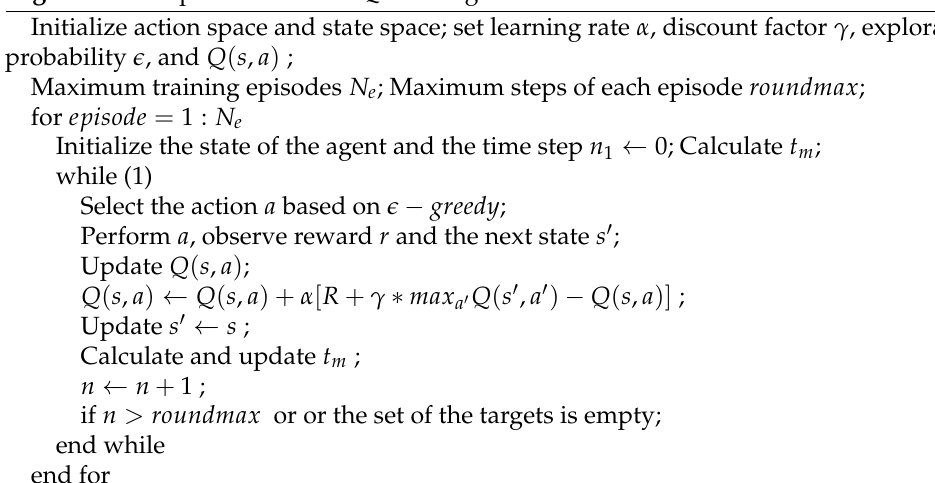
Algorithm 2 Implementation of QUEC